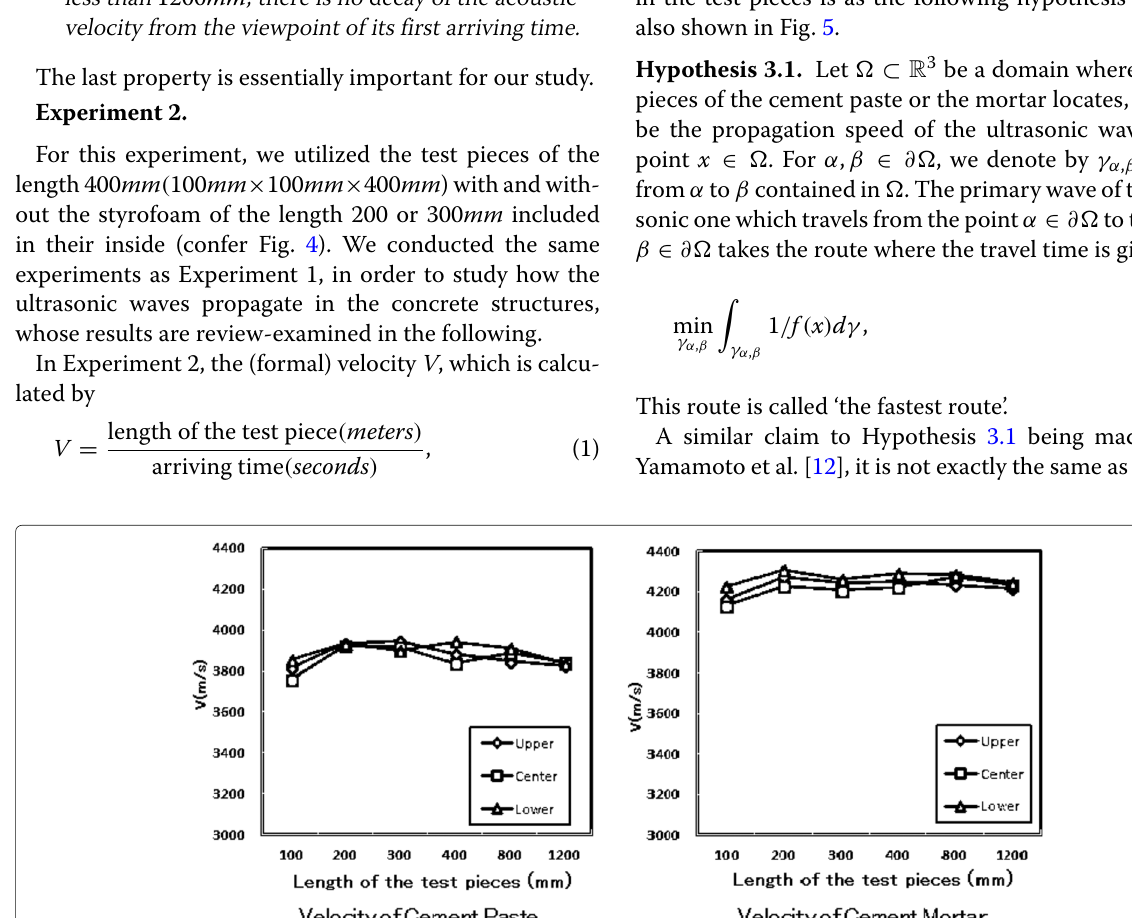
in the lower points is smaller than that of the upper points (confer Table 2 below), applying which we studied the propagation of the ultrasonic waves in the test pieces. We hypothesized that the propagation of the ultrasonic waves in the test pieces is as the following hypothesis which is also shown in Fig. 5.